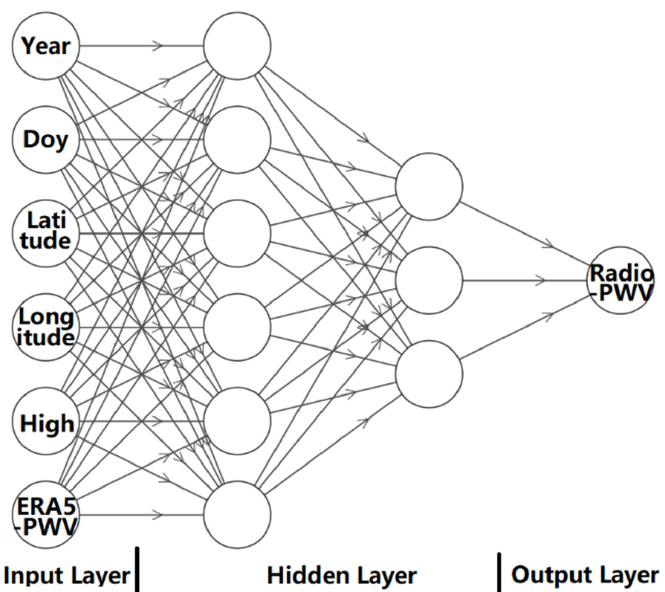
Figure 2. Structure chart of neural network.